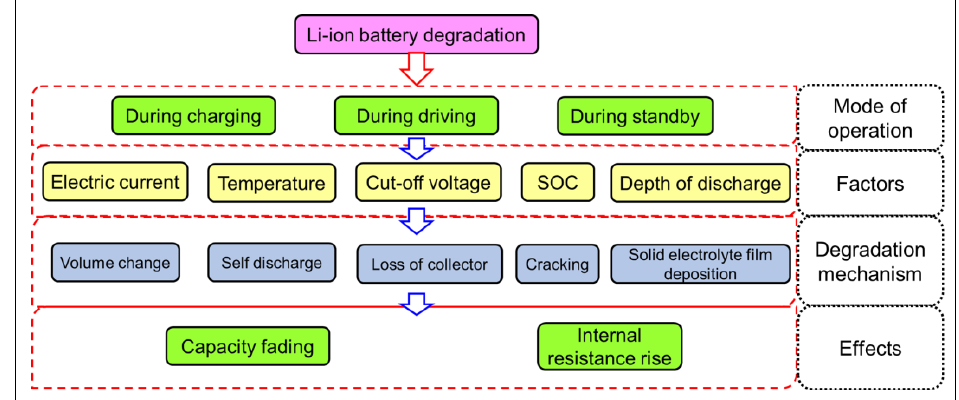
Figure 1. Battery degradation causes and effects [19].